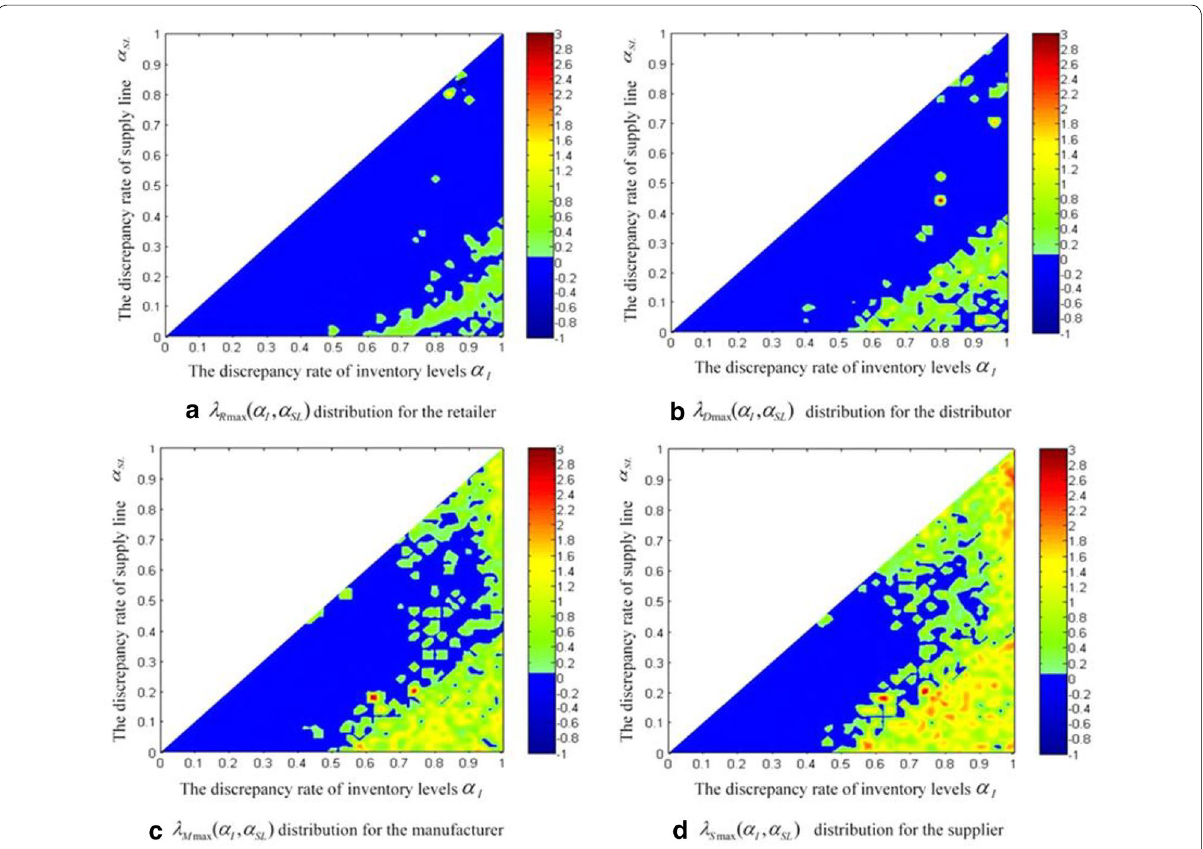
Figure 3 (cid:31) i max distribution of effective inventory for each node in the parameter space (α I , α SL